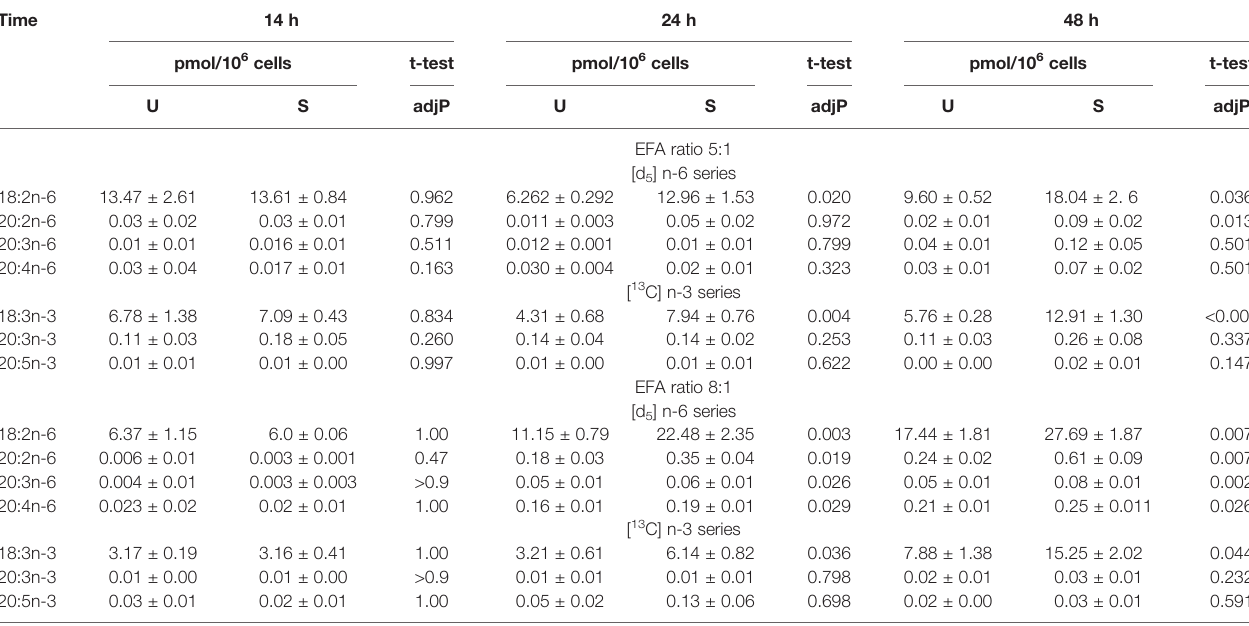
TABLE 3 | Effect of mitogen stimulation on T-cell PUFA biosynthesis.